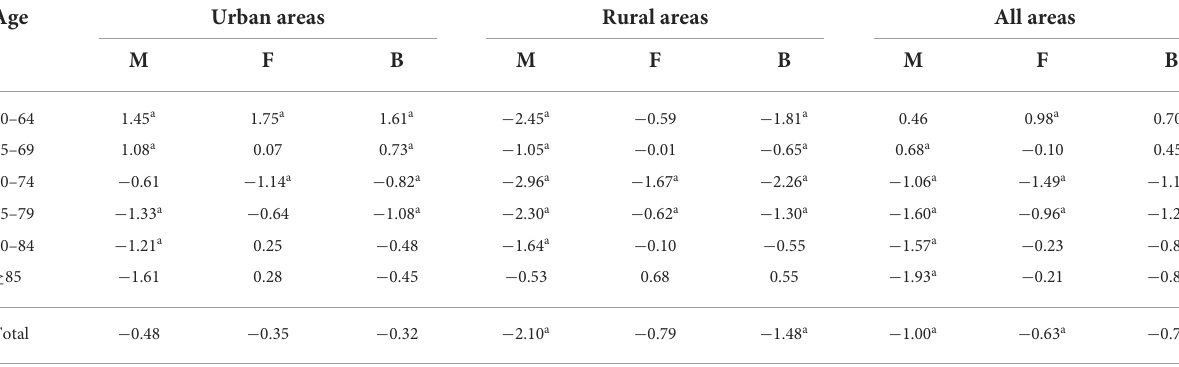
TABLE 2 The APC of cancer incidence in Chinese older adults aged 60 and above with different characteristics from 2005 to 2016 (%). Age Urban areas Rural areas All areas